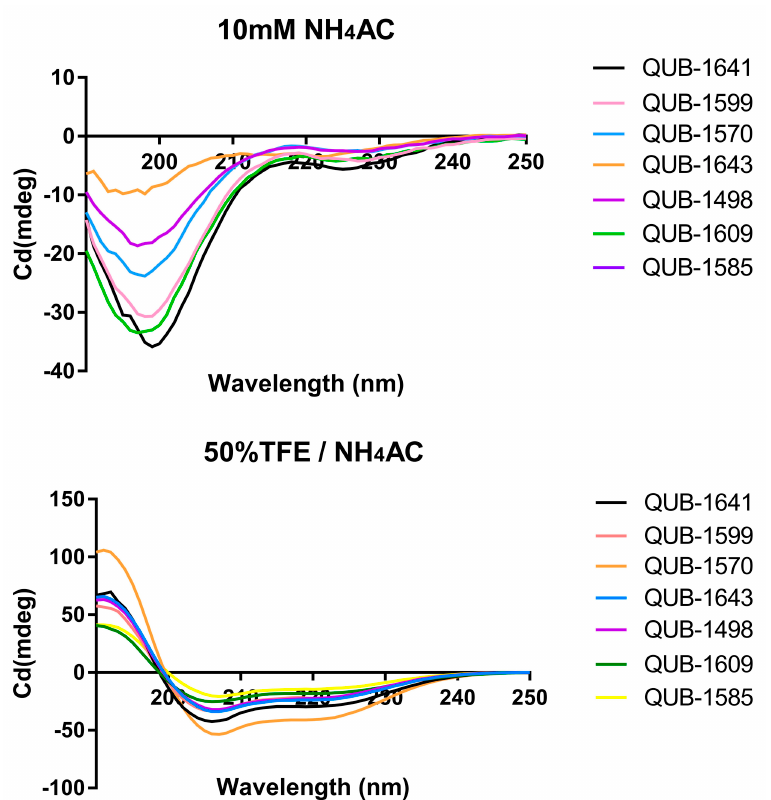
Figure 7. QUB-1641 and its analogues were dissolved at 50 µM in 10 mM NH 4 Ac solution (pH 7.4) and in 50% TFE/10 mM NH 4 Ac solution (pH 7.4) for the CD spectra. Table 2. The physicochemical properties of kassporin-KS1 (QUB-1641) and its analogues. The α -helix (%) of the peptides was calculated using the online tool Bestsel (http://bestsel.elte.hu/results.php, accessed on 25 October 2021) based on CD spectra. Table 3. MICs and MBCs of kassporin-KS1 (QUB-1641) and its analogues. 2.6. Mean Inhibitory Concentration (MIC)/Mean Bactericidal Concentration (MBC) Assays of Kassporin-KS1 (QUB-1641) and Its Analogues The antibacterial activities of kassporin-KS1 (QUB-1641) and its analogues against representative microbes are shown in Table 3. QUB-1599 was the only analogue with no inhibitory effect on all the microbes. Other analogues showed improved antibacterial activities, and their antibacterial spectra also broadened. The MICs and MBCs of QUB- 1570 and QUB-1609 against S. aureus were eightfold more potent than QUB-1641. The modification of QUB-1570 was the most successful, and this peptide specifically eliminated Gram-positive bacteria at 8 µ